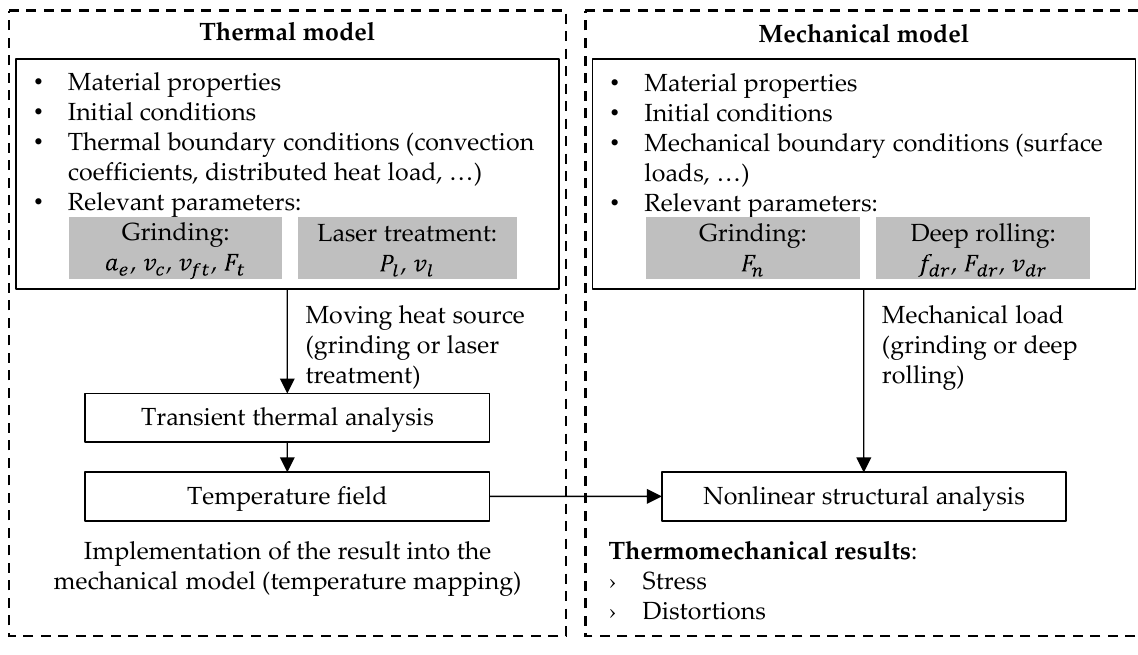
Figure 1. Thermomechanical finite element modelling strategy.